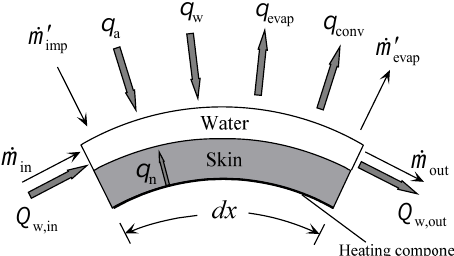
Figure 1. Control volume for the runback water on the airfoil surface.